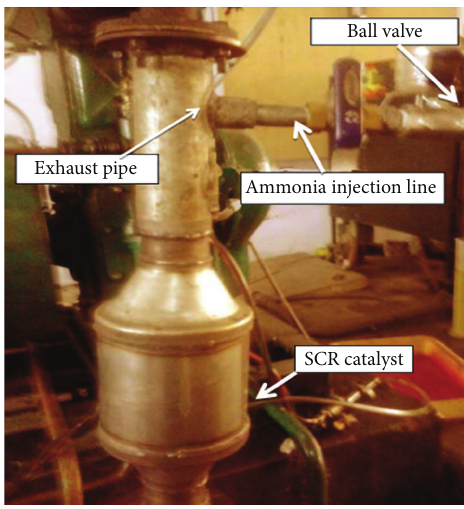
Figure 2: SCR setup. Table 1: SCR catalyst